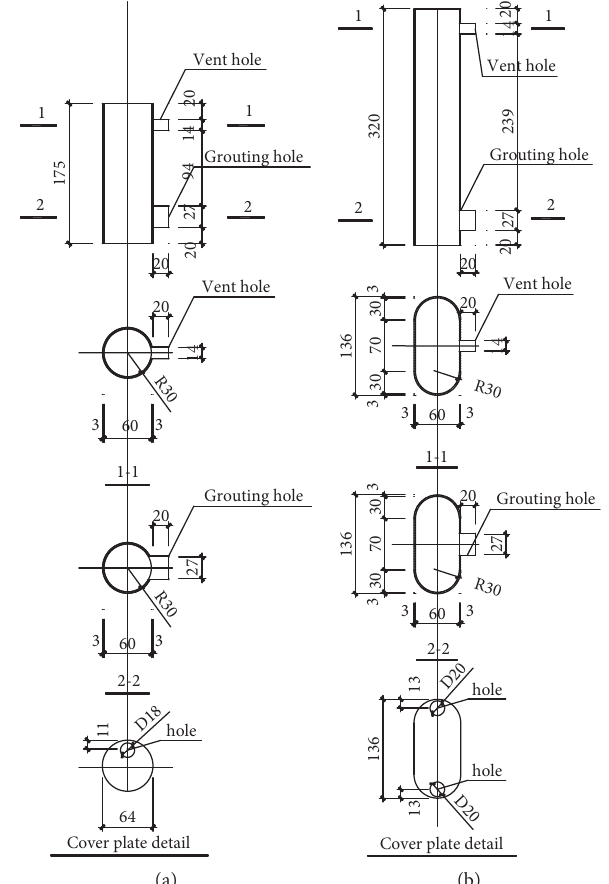
Figure 3: Details of sleeves. (a) Type-I sleeve. (b) Type-II